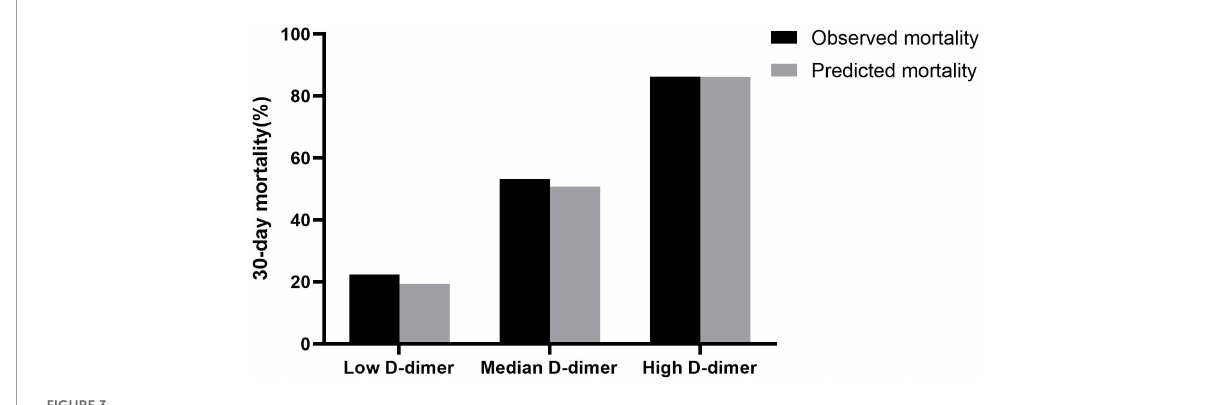
FIGURE3 Predicted and observed mortality according to low ( < 720 ng/ml), median (720–3,600 ng/ml), and high ( > 3,600 ng/ml) levels of D-dimer at 30